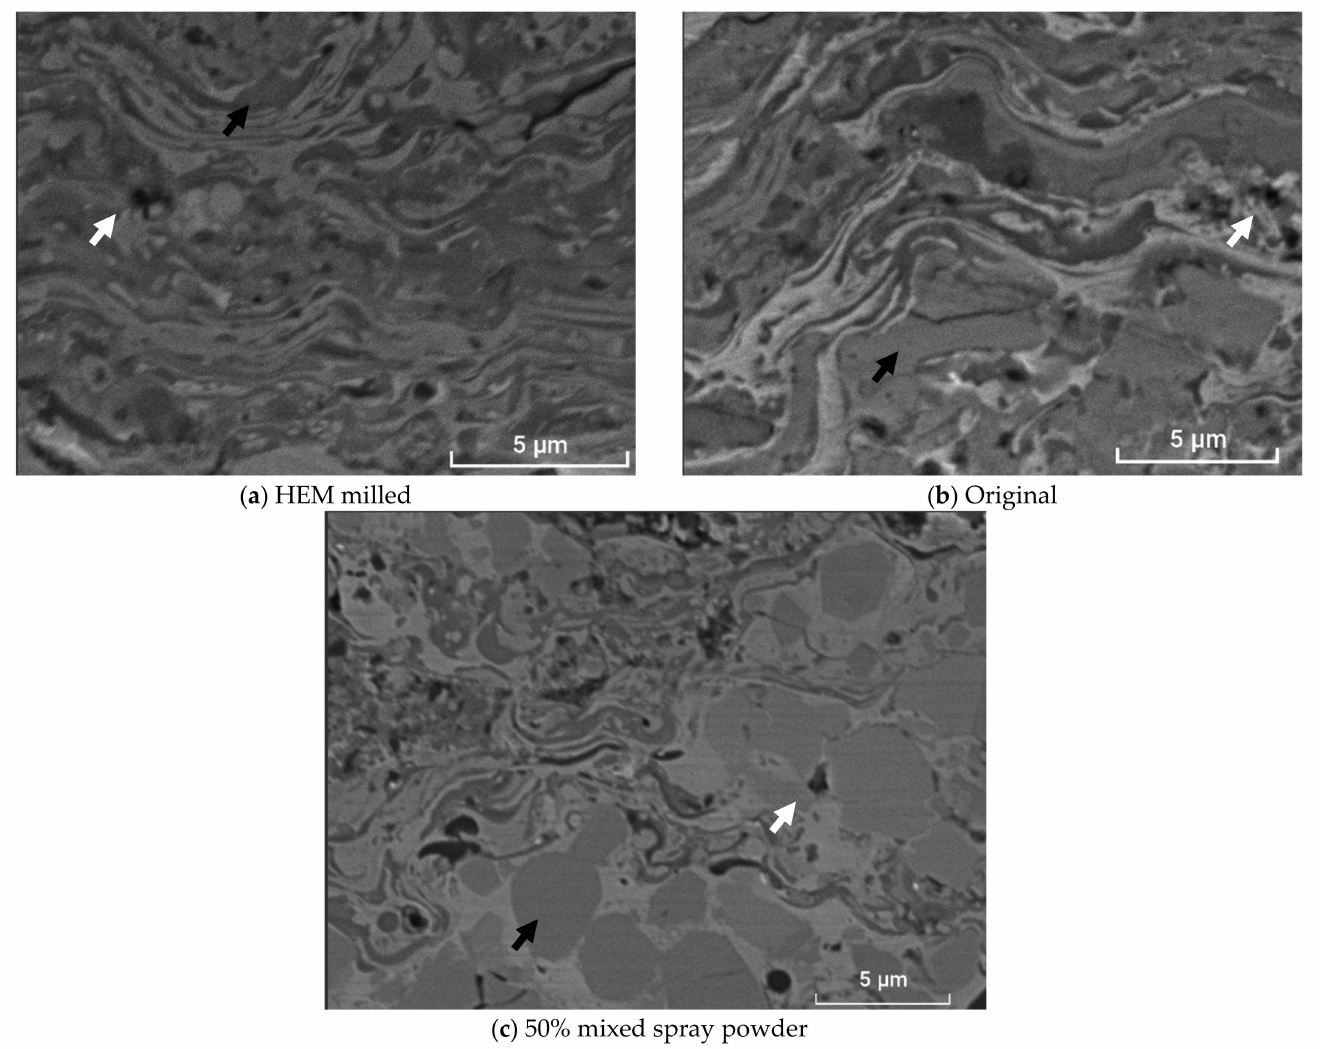
Figure 7. SEM images of the coating with powder ( a ) milled, ( b ) original, and ( c ) 50% mixed. The dark gray phases are Cr-rich Cr 3 C 2 regions, while the light gray phases represent the NiCr matrix. The dark arrows indicate carbides surrounded by the matrix. The white arrows indicate some